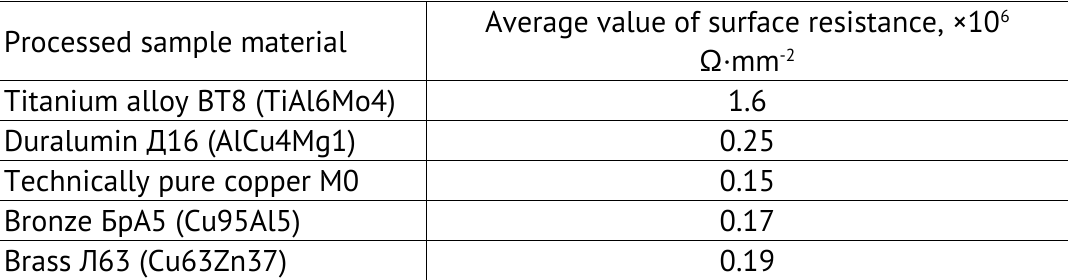
Electrical surface resistance of oxide films formed on the workpiece-cathode surfaces Processed sample